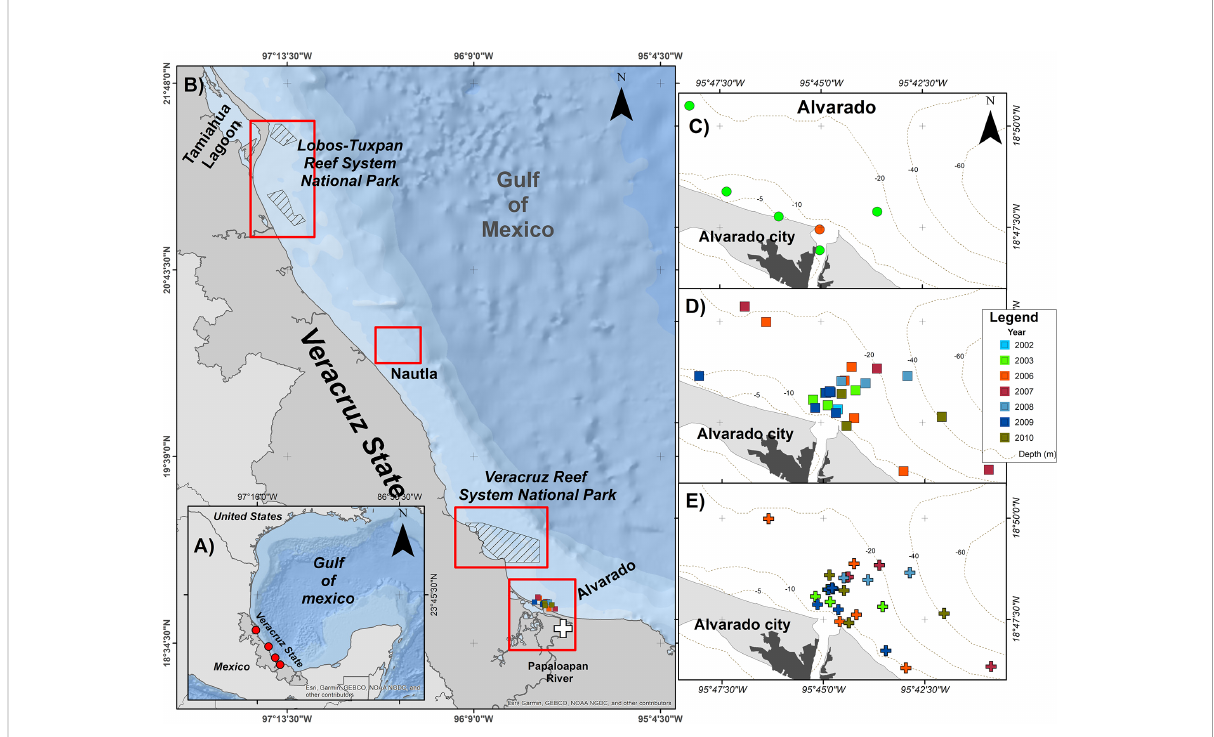
FIGURE 1 Study area along the coastal waters off Veracruz. (A) General location of bottlenose dolphin study sites in the Southwestern Gulf of Mexico (red circles). (B) Location of the sites with photo-ID catalogues and studies on skin lesions in bottlenose dolphins. (C) Recorded sightings of individual EN05. (D) individual EN10. (E) individual TN15. The white cross shows the location of the stranding of the dead male EN10 in the Papaloapan